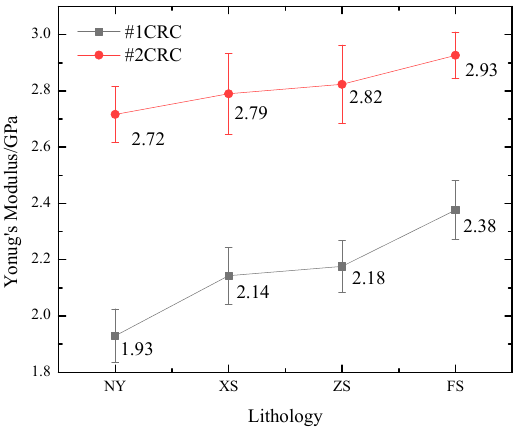
Figure 4. The Young’s modulus of the coal-rock combined (CRC) specimens.